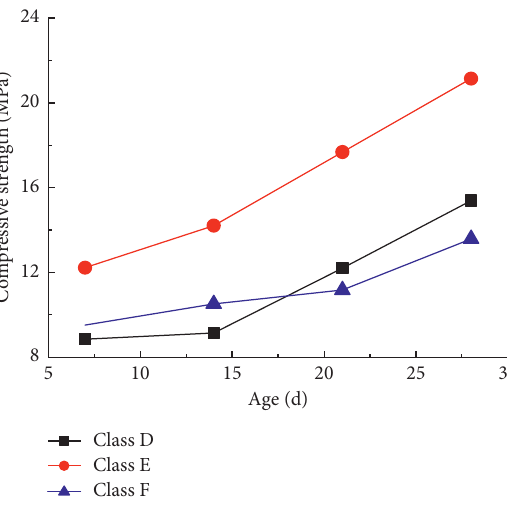
Figure 11: Compressive strength curve.